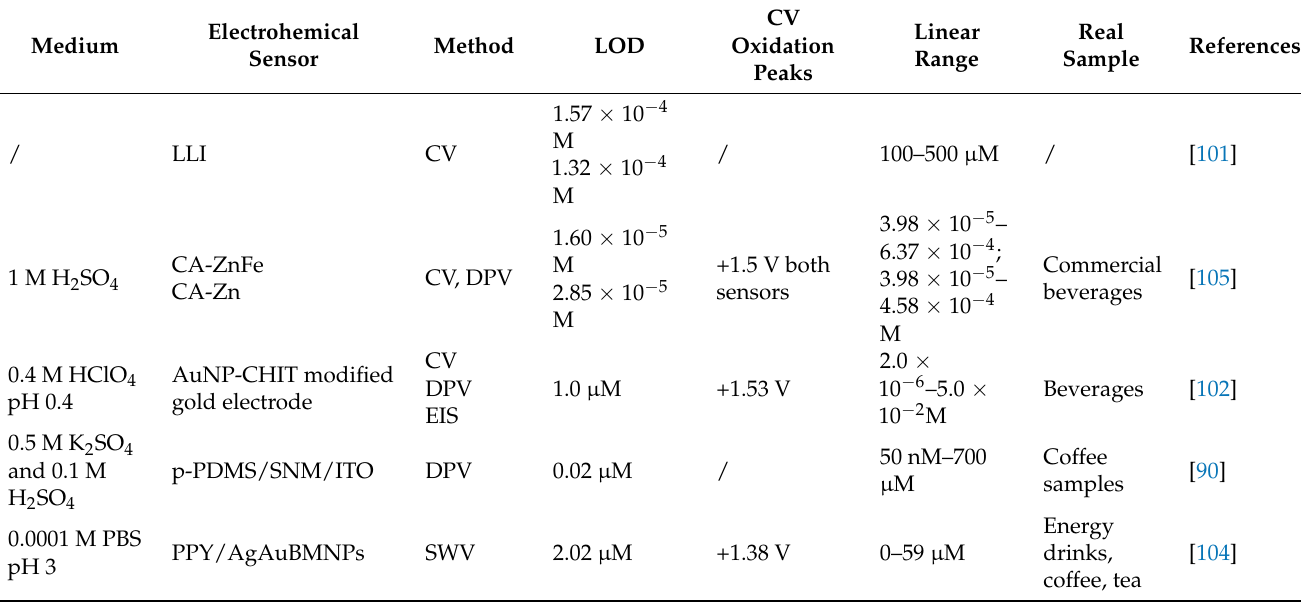
Table 7. Electrochemical characteristics of other electrodes as for caffeine